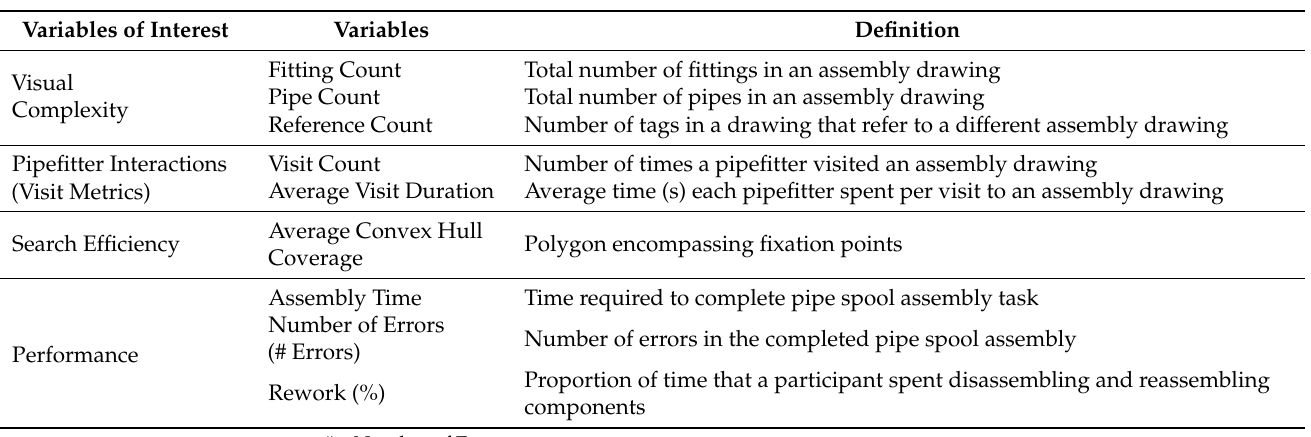
Table 3. Definition of variables.